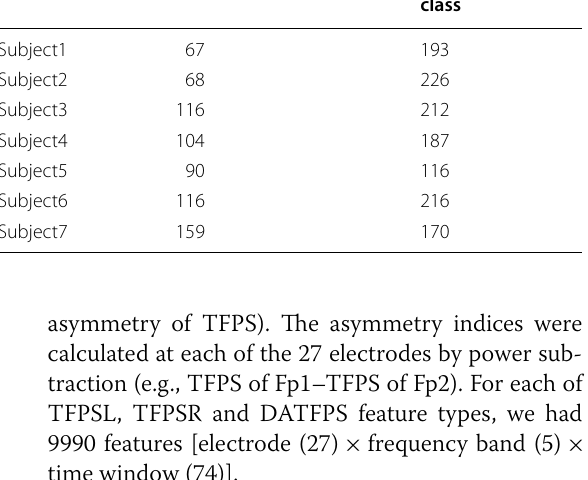
Figure 3 clarifies each step of feature extraction procedure.